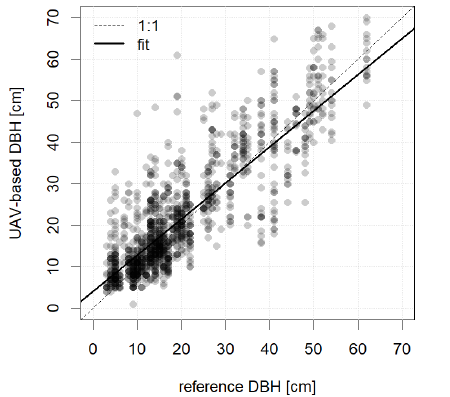
Figure 7. Scatterplot between in-situ measured DBH and the UAV-based estimates of the 5 interpreters.